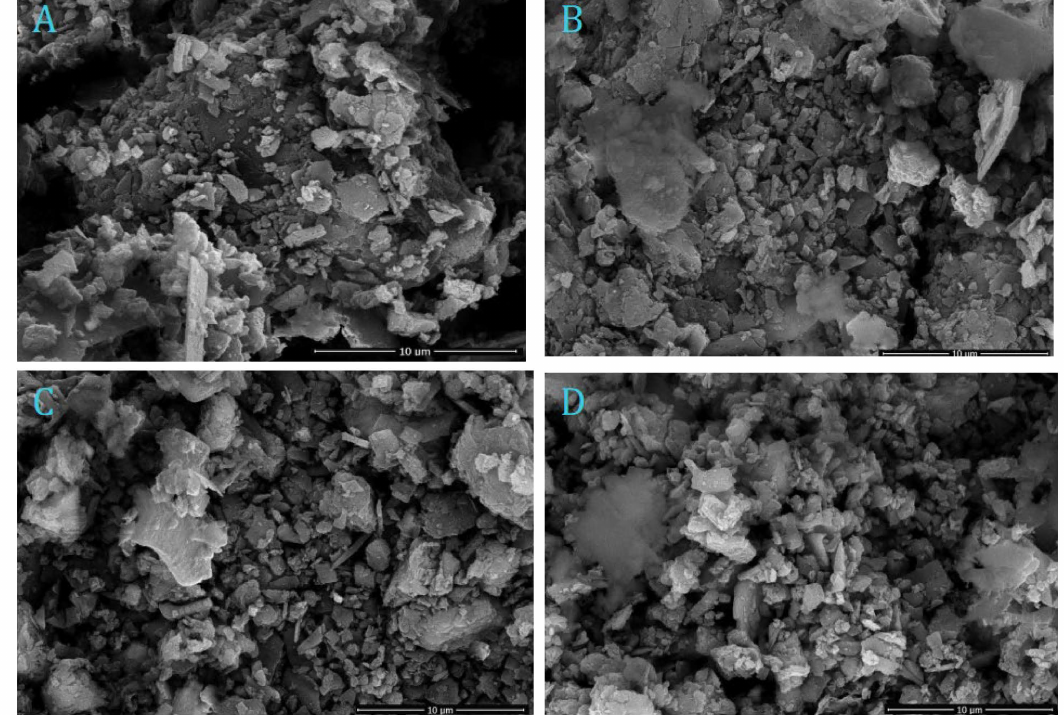
Figure 5. SEM micrograph of alum sludge ( A ) AS and calcined alum sludge ( B ) AS400, ( C ) AS600 and ( D )